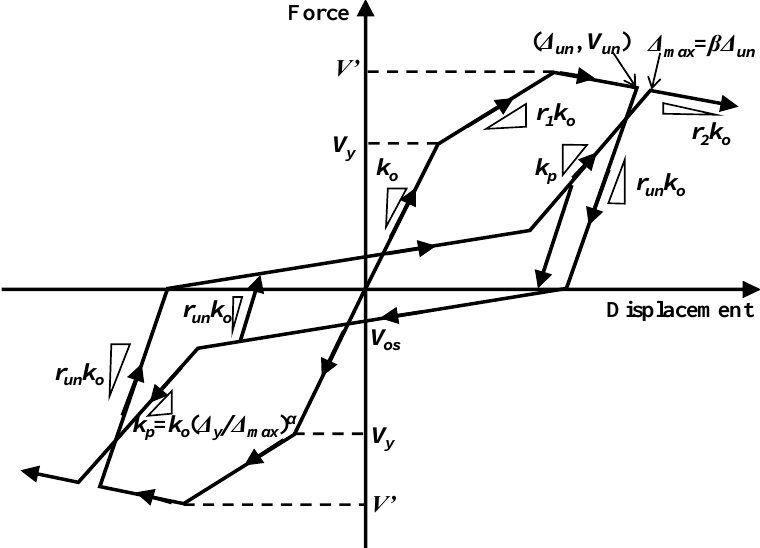
Figure 8. The hysteresis of the Wayne–Stewart model (from Carr [31]).